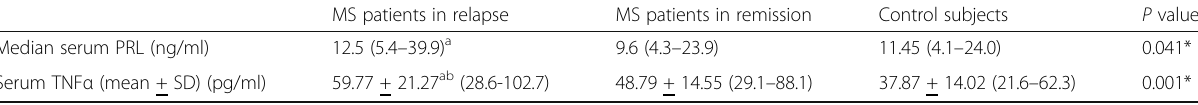
Table 1 Comparison of serum PRL and TNF α among the studied groups MS patients in relapse MS patients in remission Control